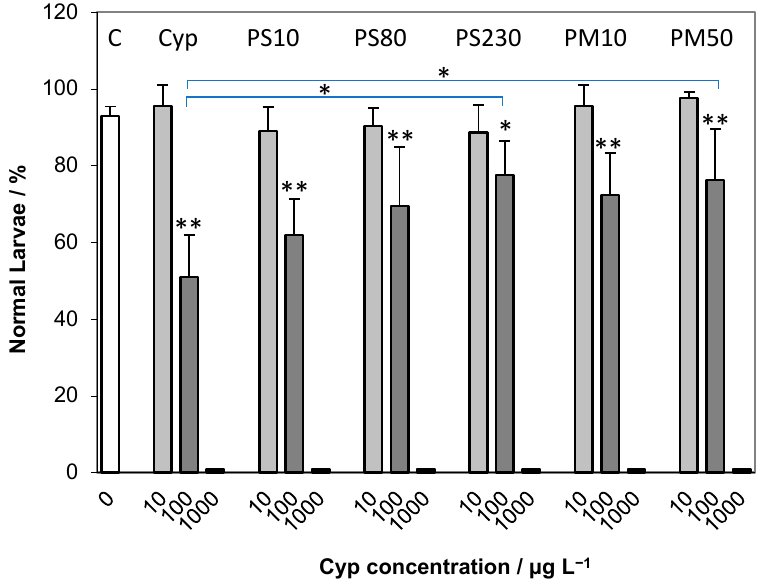
Figure 5. Percentage (mean ± SD) of normally developed plutei larvae after 72 h co-exposure to 50 mg L − 1 microparticles and various concentrations of cypermethrin (C—control, Cyp—cypermethrin only). Significant differences compared to the control (** p < 0.01) are shown at the top of the columns, while significant differences compared to cypermethrin only (* p < 0.05) are denoted by the horizontal bars.